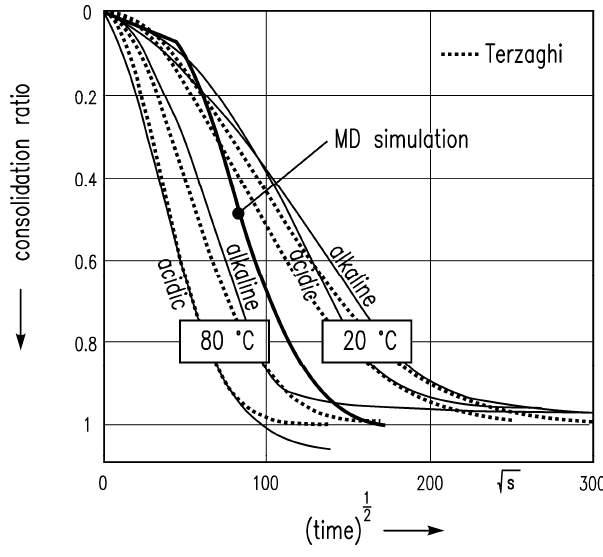
Figure 8. Computed consolidation ratio (MD-simulation) of the particulate network and experimental data from [23] as a function of time. Thin continuous curves: experimental data; dotted curves: Terzaghi model; thick continuous curve: MD